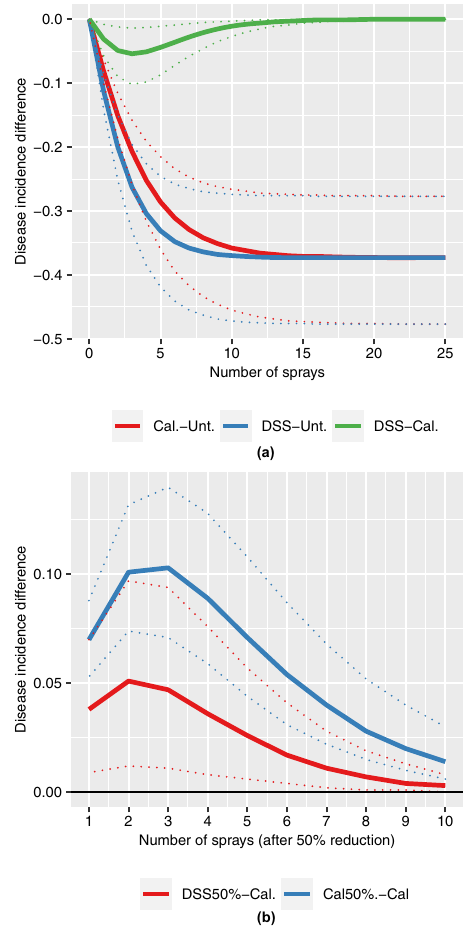
Fig. 4 Effects of the number of sprays on disease incidences for calendar- based strategy (Cal), DSS-based (DSS) strategy and untreated controls (Unt). (a) Differences in estimated disease incidence for Cal vs. Unt (Cal- Unt), DSS vs. Unt (DSS-Unt) and DSS vs. Cal (DSS-Cal) strategies for numbers of sprays ranging from 0 – 25; ( b ) Differences in estimated disease incidence resulting from the application of DSS and Cal strategies with a number of sprays reduced by 50% compared to total number recommended by the original Cal strategy. In ( a ), the same number of sprays is considered for both DSS and Cal, and the green curve reveals that DSS leads to lower levels of disease incidence than Cal when the same number of sprays are applied with both strategies. In ( b ), the curves DSS50%-Cal and Cal50%-Cal indicate the extent of the increase in disease incidence resulting from a reduction of 50% of the total number of sprays recommended by the original calendar strategy. The disease incidence is increased with both DSS50% and Cal50% compared to Cal, but the level of increase is lower with the former than with the latter. The different curves describe the posterior medians (solid line) and the 95% credible intervals (dotted lines) (95%